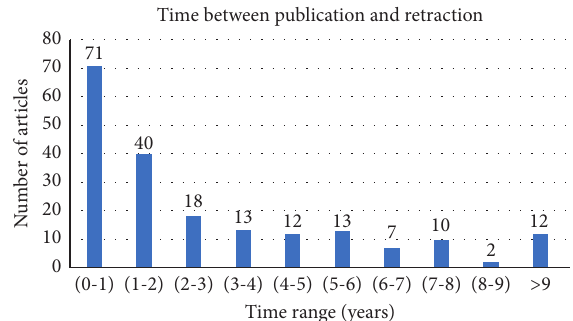
Figure 2: Graph showing the time duration between original paper publication and its retraction. N �